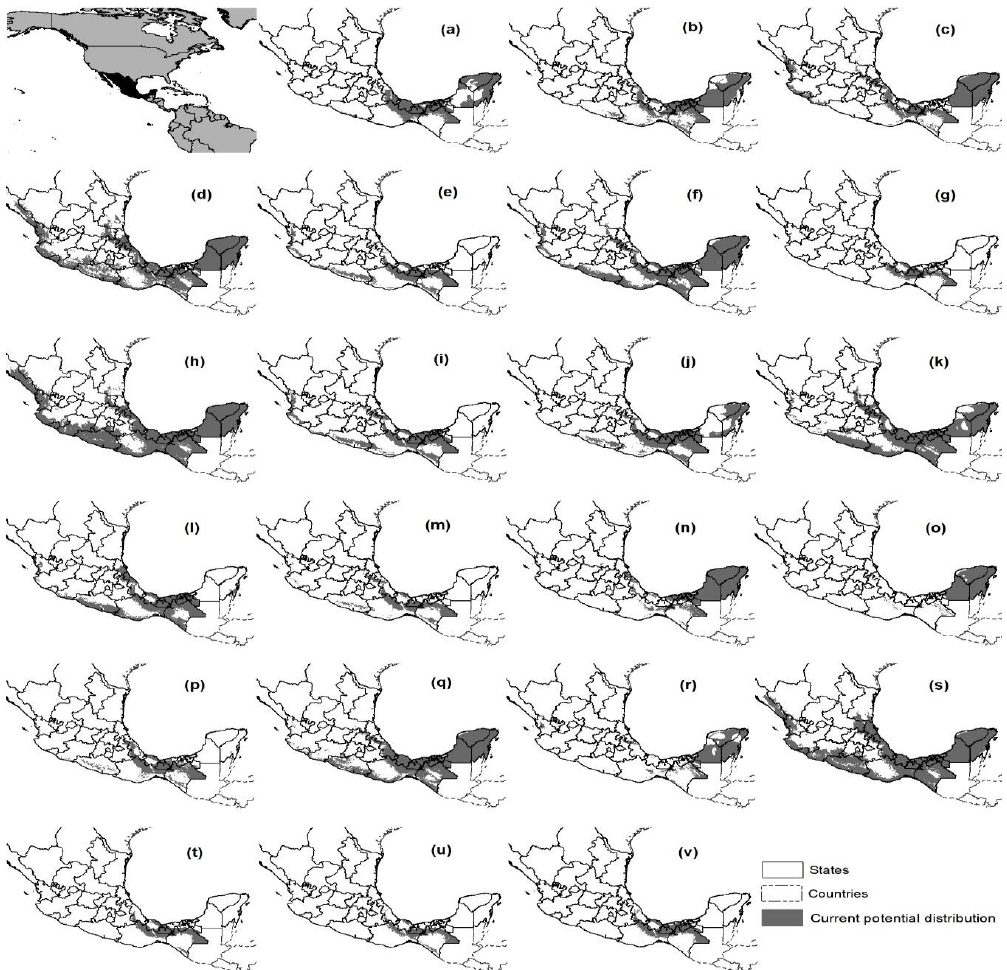
Figure 2. Current potential distribution of the species. ( a ) Annona glabra ; ( b ) Aspidosperma megalocarpon ; ( c ) Brosimum alicastrum ; ( d ) Bursera simaruba ; ( e ) Calophyllum brasiliense ; ( f ) Cecropia obtusifolia ; ( g ) Dialium guianense ; ( h ) Enterolobium cyclocarpum ; ( i ) Guarea glabra ; ( j ) Guatteria anomala ; ( k ) Heliocarpus donnell-smithii ; ( l ) Licania platypus ; ( m ) Magnolia mexicana ; ( n ) Manilkara zapota ; ( o ) Pouteria campechiana ; ( p ) Schefflera morototoni ; ( q ) Spondias mombin ; ( r ) Swietenia macrophylla ;